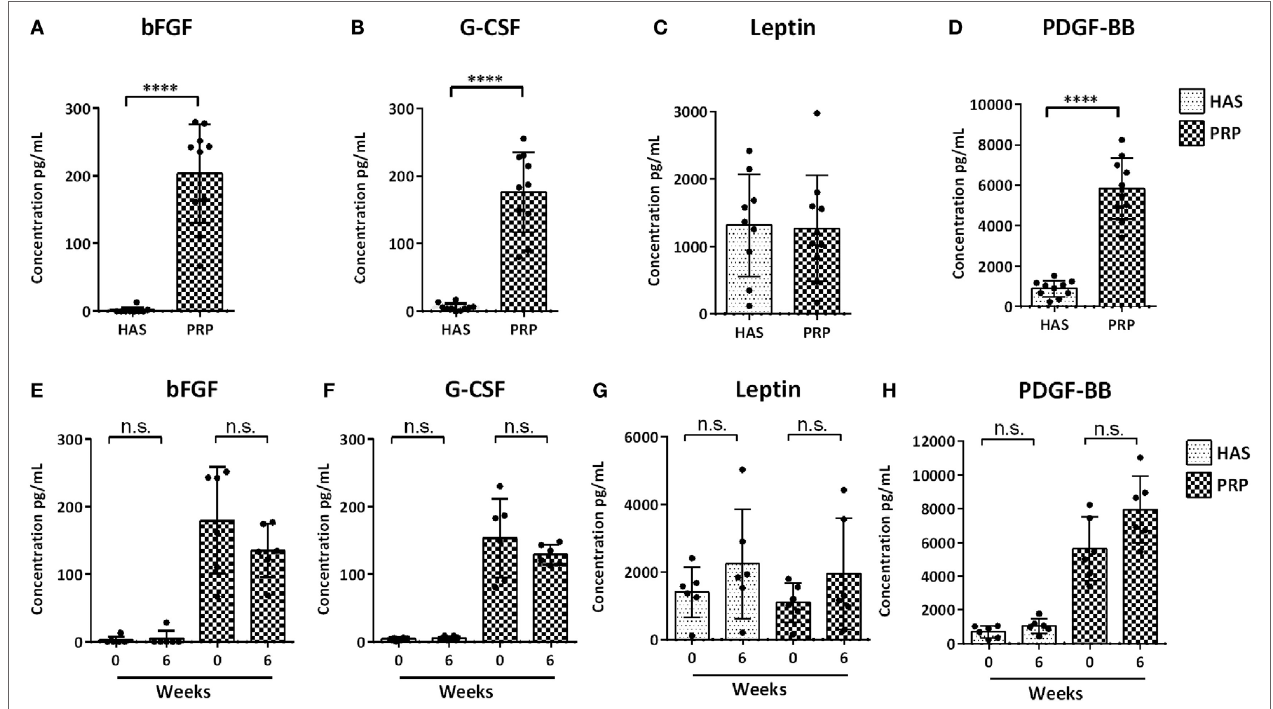
FigUre 1 | Analysis of determined protein content of hyperacute serum (HAS) and platelet-rich plasma (PRP) from 10 individual blood donors (a–D) and differences in protein levels isolated from 6 blood donors at 0 and 6 weeks for determining differences in protein levels to different isolation time points (e–h) determined by a multiplex bead-based array. Data represented as mean ± SD. Statistically significant is denoted by **** p <